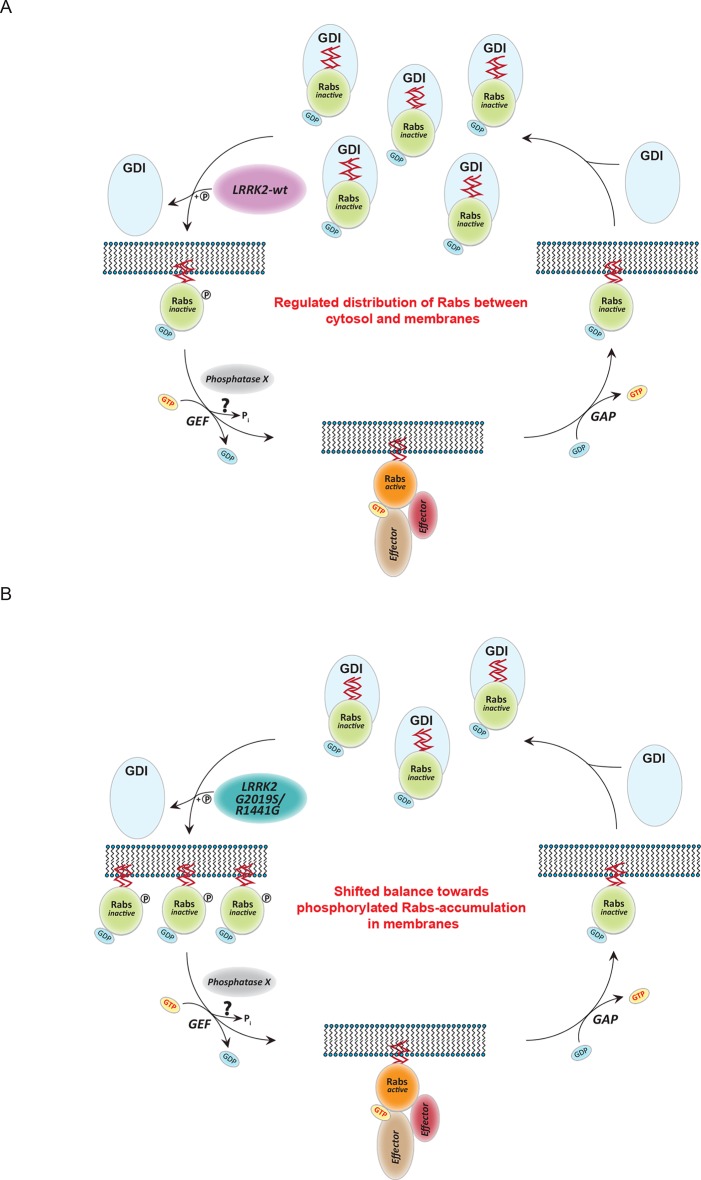
Model of Rab GTPase phosphorylation by LRRK2 and its outcome.(A) Rab GTPases (Rabs) cycle between an inactive (GDP-bound) and an active state (GTP-bound) between cytosol and membranes, respectively. Geranyl-geranyl-modified Rab GTPases in their GDP-bound state are tightly bound by guanine dissociation inhibitors (GDIs) in the cytosol. LRRK2 aids the insertion of Rabs in their specific target membrane. After removal of the LRRK2 phosphorylation site, guanine exchange factors (GEFs) facilitate exchange of GDP to GTP. This in turn allows binding to effector proteins and membrane trafficking events. Next, a Rab-specific GTPase-activating protein (GAP) assists in the hydrolysis of GTP followed by removal of the Rab GTPase from the target membrane by GDIs. (B) In pathogenic conditions, in which LRRK2 is hyperactive, RabGTPases have strongly diminished affinities for GDIs. As a result, the equilibrium between membrane-bound and cytosolic Rabs is disturbed, which may contribute to LRRK2 mutant carrier disease phenotypes. Model adapted and modified from (Hutagalung and Novick, 2011).